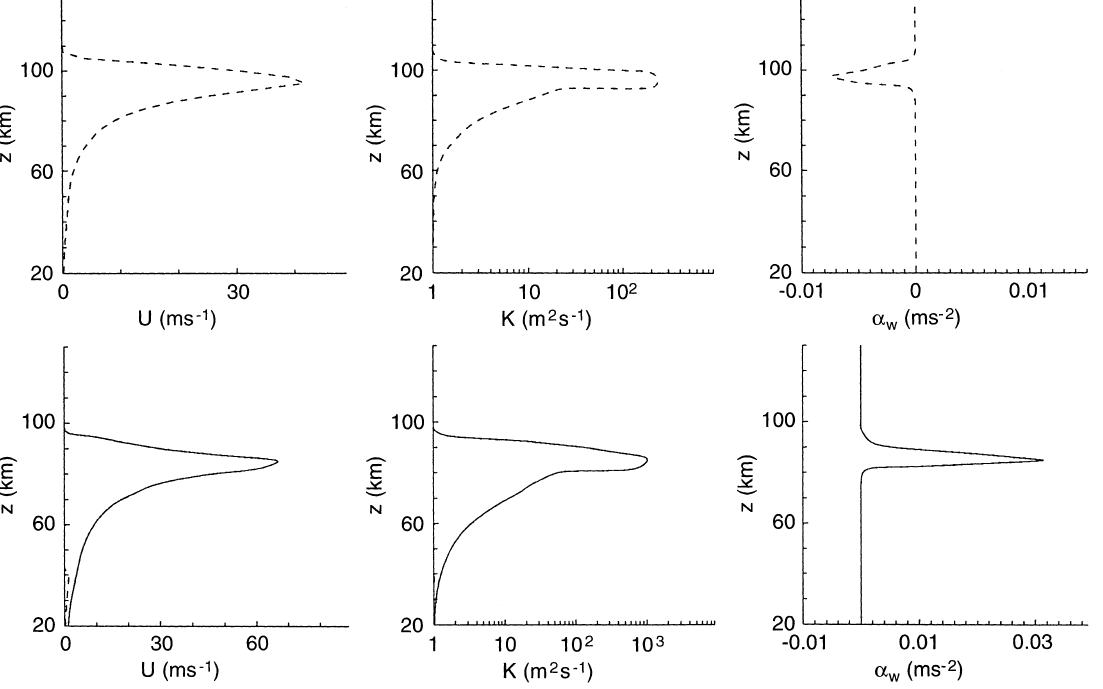
plots ). Tropospheric wave source is the same as in Fig. 1. Definition of the parameters see Fig. 2